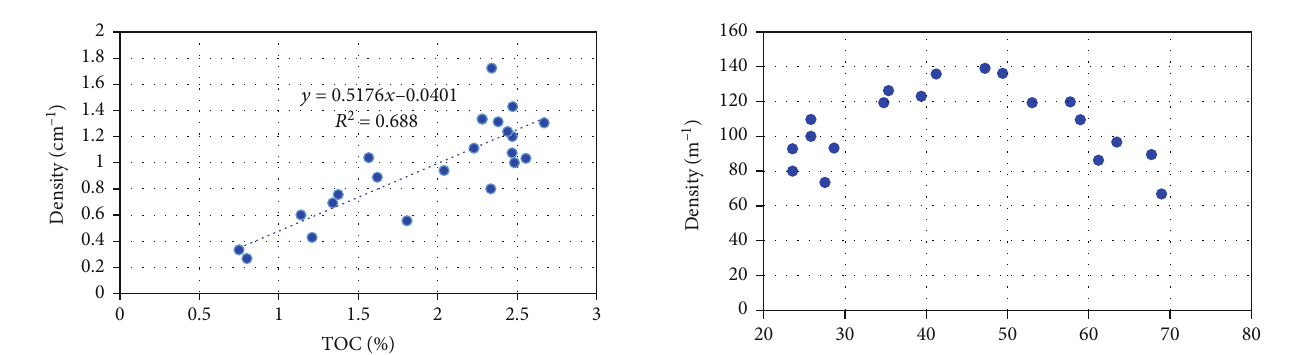
Figure 5: Relationship between density and aperture of lamellation fractures in the Qianjiang Depression.